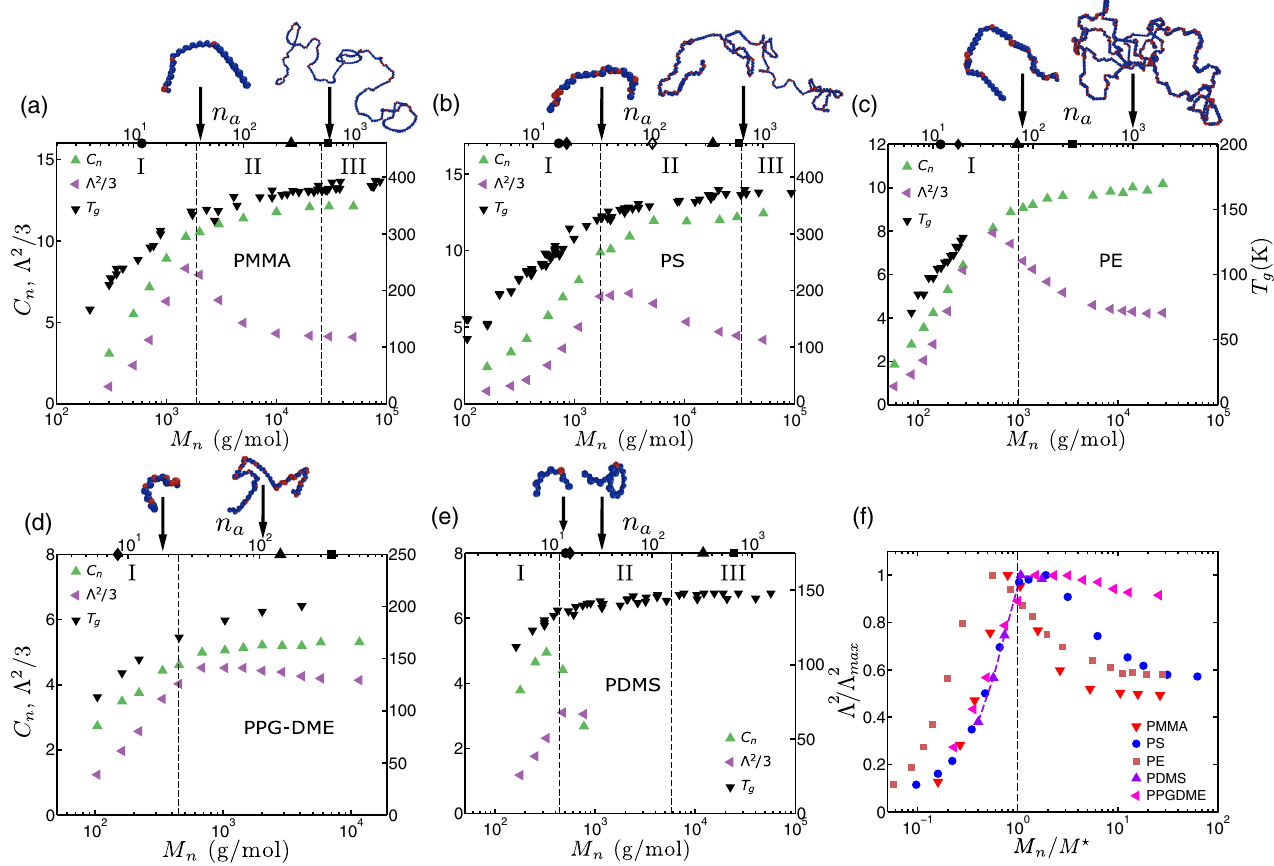
FIG. 3. (a) – (e) Glass-transition temperature T (inverted black triangles) from Fig. 2; the Flory characteristic ratio C (green triangles); g n and the aspect ratio Λ 2 ¼ λ 2 3 = λ 2 1 , where λ 2 3 and λ 2 1 are, respectively, the largest and smallest eigenvalues of the average polymer and Λ 2 are determined conformational tensor (purple triangles) for (a) PMMA, (b) PS, (c) PE, (d) PPG-DME, and (e) PDMS. Here, C n 200 K for PE. The symbols on the top axes (filled M Þ for PMMA, PS, PPG-DME, or at T from RIS simulations performed at T g ð g ¼ black circle, filled black diamond, diamond, filled black triangle, filled black square) identify characteristic molecular weights as in Fig. 2. For each polymer chemistry, two typical molecular configurations are shown at the M indicated with arrows; here, bonds in excited dihedral states are shown in red. The dashed lines identify the crossovers between regimes I and II (at M ⋆ ) and II and III (at M (cid:2)(cid:2) ). vs M=M (cid:2) , where all maxima Λ 2 occur for M ≃ M ⋆ (f) Λ 2 = Λ 2 max max